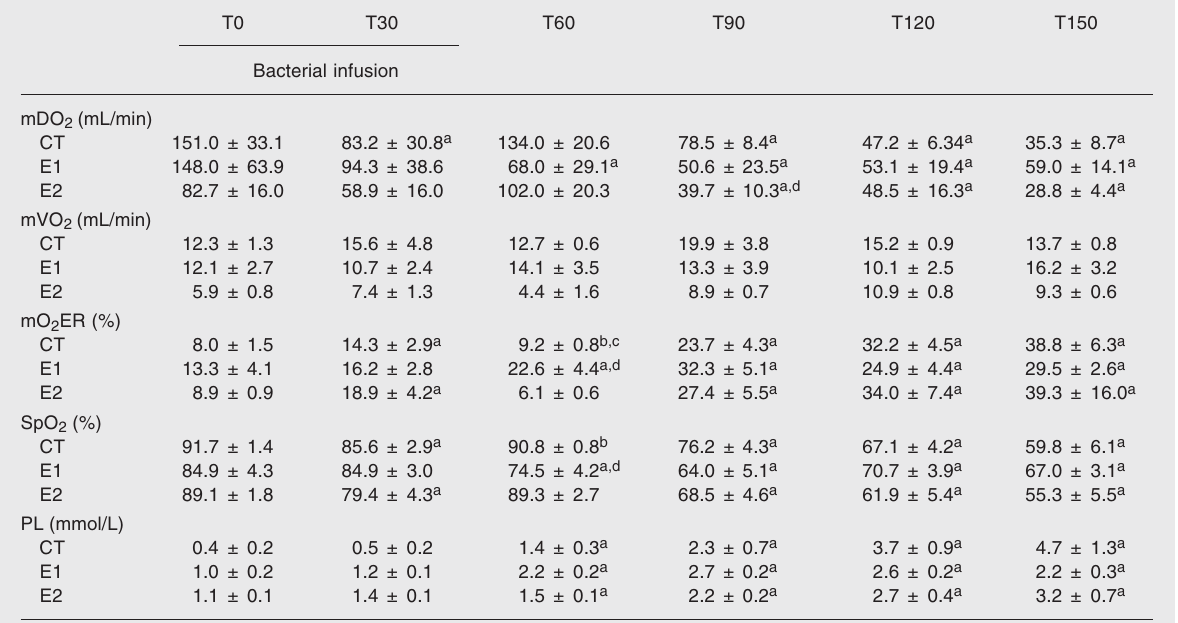
Table 2. Regional oxygen-derived variables for all groups.